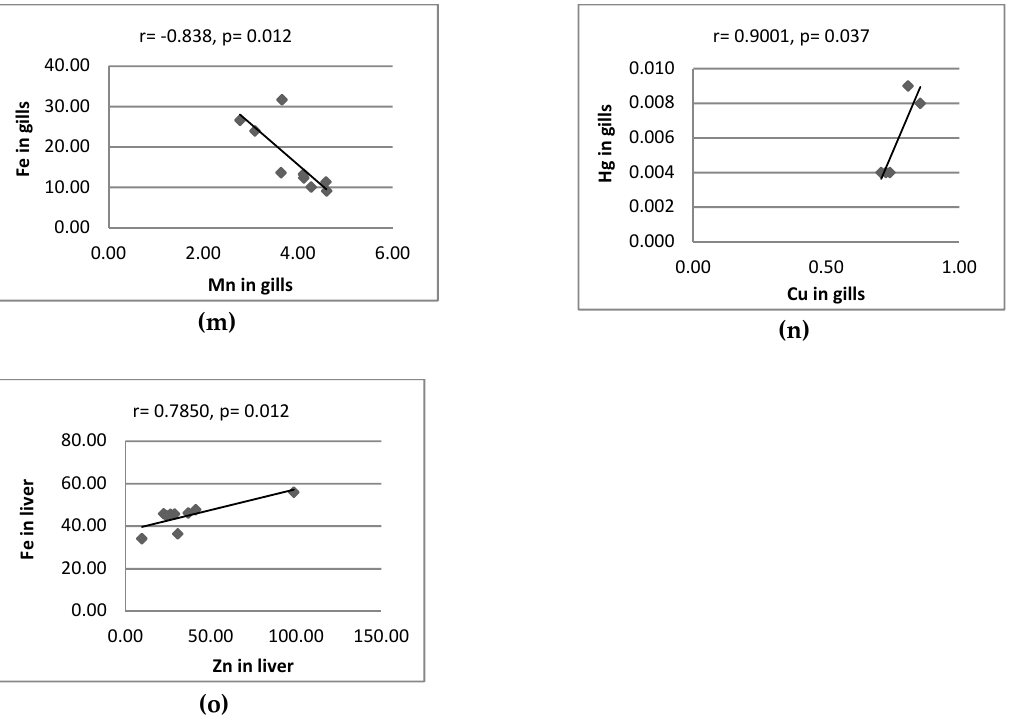
Figure 3. Correlation between contents of metal (mg/kg wet weight); r—correlation coefficients; p — significant level; ( a ) pike, ( b ) pike, ( c ) perch, ( d ) perch, ( e ) perch, ( f ) perch, ( g ) roach, ( h ) perch, ( i )